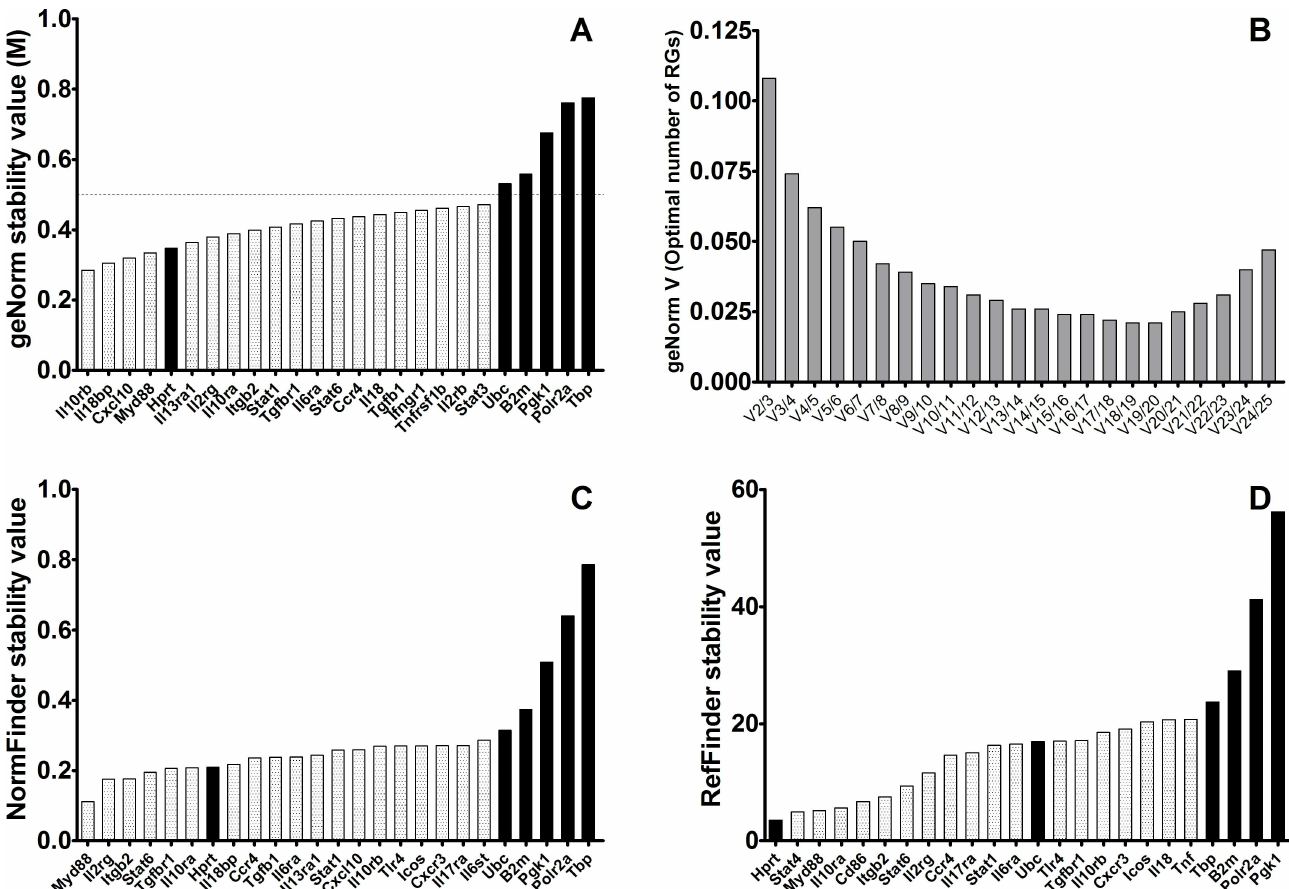
Fig 1. Stability values of the best candidatereferencegenes(lightgray) and 6 six classicalreference genes(black bars) in spleensamples of controlBALB/c mice.A) M-stability value according to geNorm;horizontalline marksthe threshold stabilityvalue M = 0.5. B) Pairwise variation ( V n/n+1 ) between the normalization factors of the samplesaccordingto geNorm. C) Stabilityranking accordingto NormFinder. D) Stabilityranking accordingto RefFinder. Lower values indicatehigherstabilityfor all rankings.